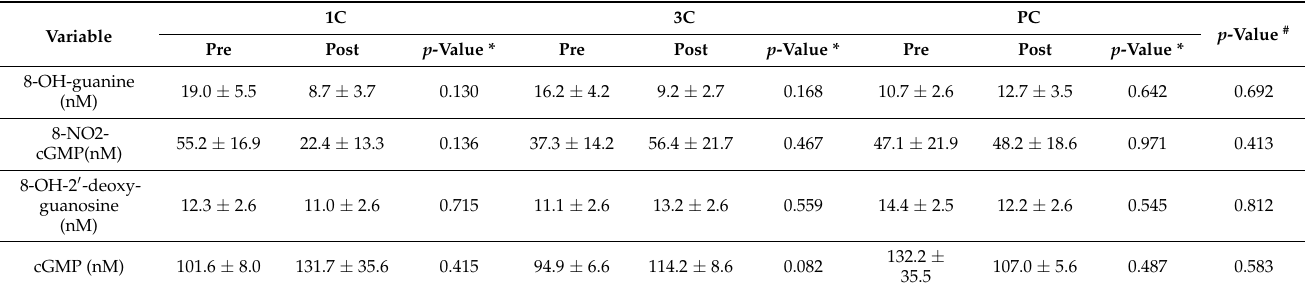
Table 3. Markers of DNA oxidation catabolites in plasma after each treatment ( n = 21).